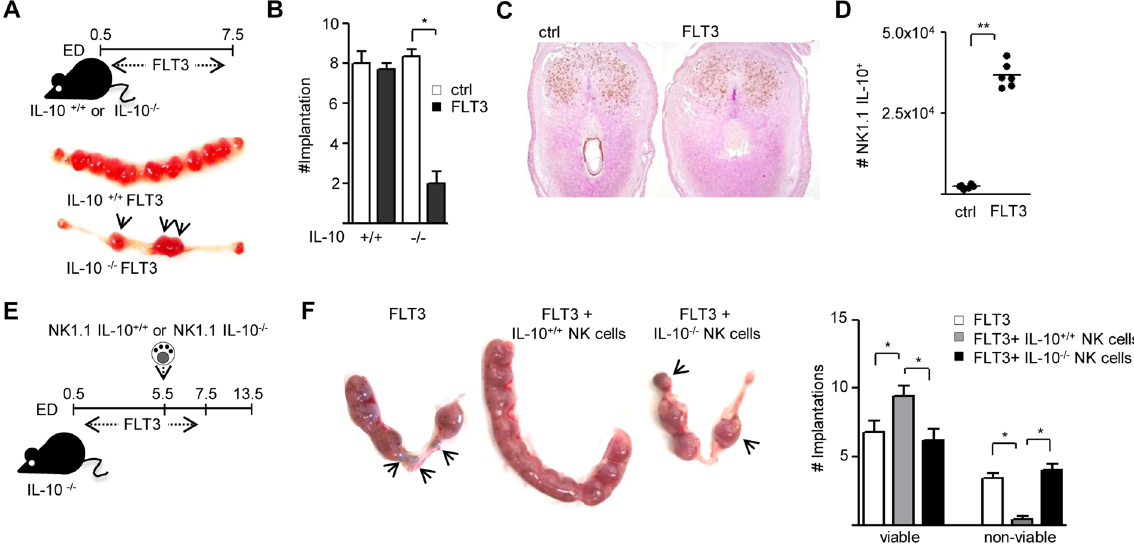
Figure 3. IL-10 + NK cells promote fetal survival in FLT3 treated IL-10 − / − mice. ( A ) Top panel: Protocol scheme for FLT3 treatment in female mice during early gestation. C57BL/6 females (IL-10 + / + or IL-10 − / − ) were treated with FLT3 from ED0.5 to ED7.5, as described in Methods. Bottom panel: Representative images of the macroscopical appearance of the uterus and implantation sites registered during ED7.5. The pictures show the normal phenotype of IL-10 + / + implantation sites in contrast to that observed in IL-10 − / − mice, which exhibit less implantations. ( B ) Number of implantations observed after FLT3L treatment in IL-10 + / + and IL-10 − / − dams on ED7.5. ( C ) Left panel: Representative images showing DBA-PAS staining of whole implantation sections harvested on ED7.5 from IL-10 + / + mice in which DC had been expanded with FLT3. ( D ) Absolute numbers of IL-10 expressing NK1.1 cells in control and FLT3 treated IL-10 + / + dams. In figures ( B ) and ( D ) data are depicted as the mean ± SEM derived from six to eight mice per group. * p < 0.05 and ** p < 0.001 analyzed by the Mann-Whitney U test. ( E ) Experimental design for adoptive transfer of IL-10 + / + NK cells during early pregnancy. Upon plug detection; IL-10 − / − mice were injected daily with 10 μ g FLT3 i.p. from ED0.5 to ED7.5. IL-10 + / + or IL-10 − / − NK1.1 cells were then adoptively transferred to IL-10 − / − mice upon FLT3 treatment on ED5.5. ( F ) Left panel: macroscopical appearance of the uterus on E13.5. The pictures show the normal phenotype of FLT3 treated IL-10 − / − dams transferred with IL-10 + / + NK cells in contrast to that observed in FLT3 treated IL-10 − / − dams transferred or not with IL-10 − / − NK cells mice, which exhibit resorbed fetuses; Right panel: Number of viable and non-viable implantations from FLT3 treated IL-10 − / − dams transferred or not with IL-10 + / + or IL-10 − / − NK cells observed on ED13.5. Data shown are mean ± SEM derived from six mice per group. * p < 0.05 analyzed by the Tukey’s